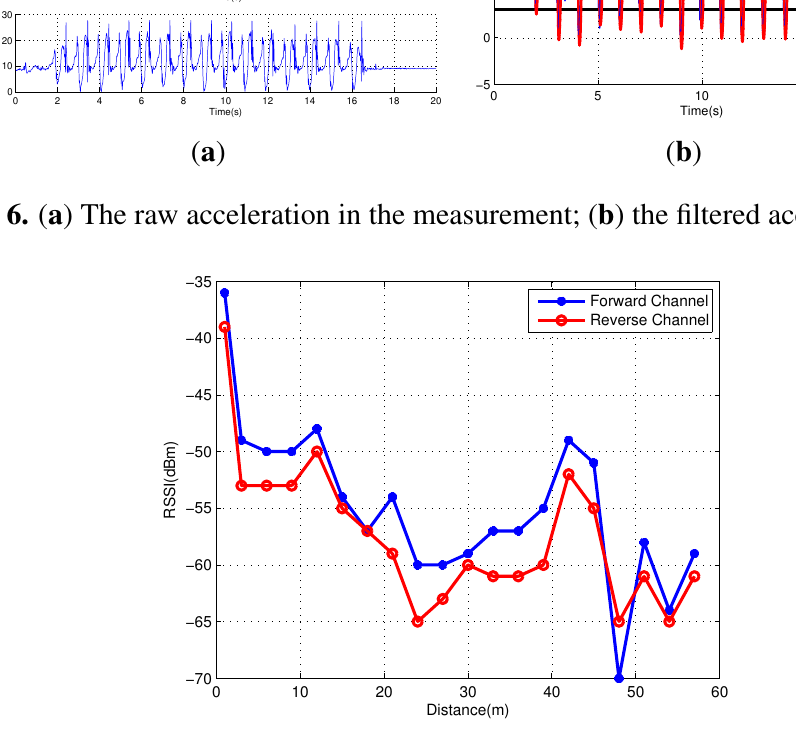
Figure 7. The value of the RSSI record by two